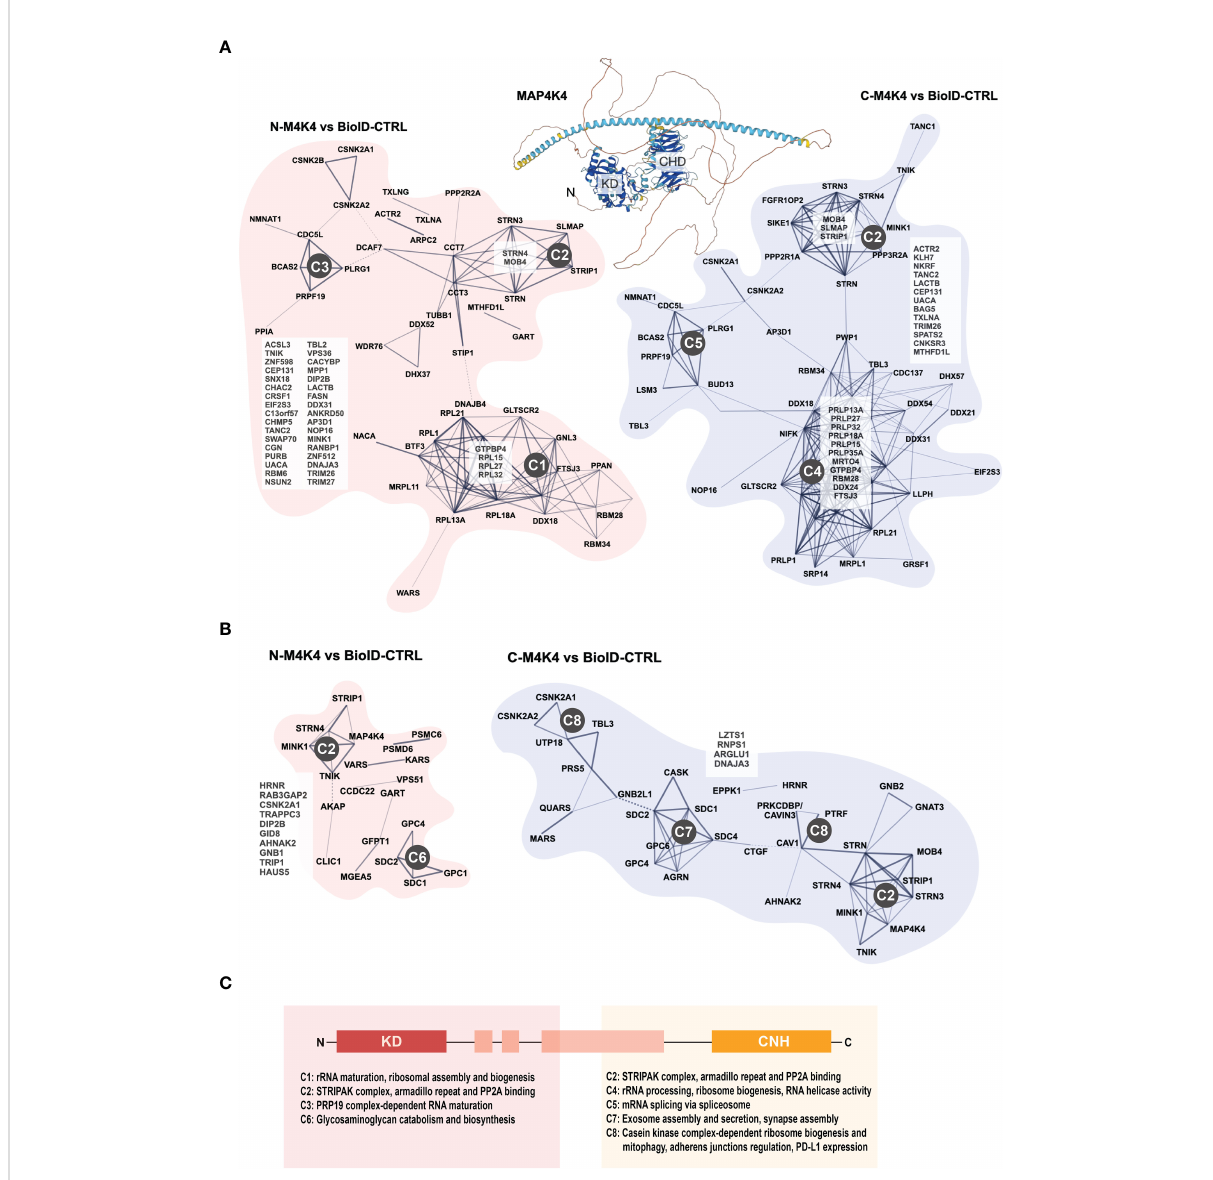
FIGURE 5 Protein interaction clusters of MAP4K4. (A) STRING protein interaction database analysis of proteins identi fi ed as MAP4K4 interactors in HEK293T cells using N- or C-terminally fused biotin ligase. Network: full STRING network; edges: con fi dence; active interaction sources: Textmining, experiments, databases, K-means clustering. Using STRING protein-protein interaction and functional enrichment analysis, three distinct clusters can be identi fi ed among the proteins identi fi ed using N-terminally-fused biotin ligase. C1: Proteins associated with the biological processes ribosomal RNA (rRNA) maturation, ribosomal assembly and biogenesis and the molecular functions RNA binding molecules and structural constituents of the ribosome. C2: STRIPAK complex proteins with the molecular function armadillo repeat domain and protein phosphatase 2a binding. C3: Proteins involved in mRNA maturation comprise components of the PRP19 complex and the U2-type catalytic step 2 spliceosome. C4: Proteins associated with the maturation of precursor Large SubUnit (LSU) ribosomal RNA (rRNA) molecules into mature LSU- rRNA molecules, rRNA processing and ribosome biogenesis. C4 molecular functions include RNA helicase activity, RNA binding and processing. C5: Proteins involved in mRNA splicing via the spliceosome and associated with the PRP19 complex and the U2-type catalytic step 2 spliceosome. (B) STRING protein interaction database analysis of proteins identi fi ed as MAP4K4 interactors in DAOY cells using N- or C- terminally fused biotin ligase. Analysis as in (C) C6: Proteins involved in glycosaminoglycan catabolism and biosynthesis, with predicted association with lysosomal and Golgi lumens, the plasma membrane, collagen-containing extracellular matrix and the cell surface. C7: Proteins associated with positive regulation of exosome assembly and secretion, regulation of neurotransmitter receptor localization and synapse assembly. C7 proteins are predicted to be associated with the plasma membrane, the cell surface, cell junctions and the lumen of intracellular organelles. C8: Proteins of the casein kinase 2 complex and of the small subunit processome, predicted implication in ribosome biogenesis, mitophagy, adherens junction regulation and PD-L1 expression in cancer. (C) Predicted biological processes of protein clusters identi fi ed by MAP4K4 N- and C-terminus directed proximity